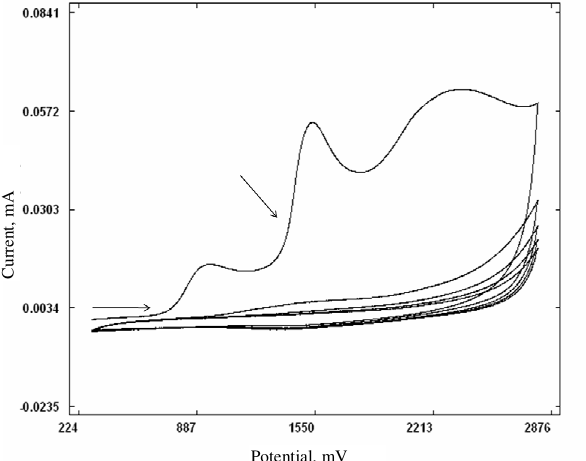
Figure 2 . Cyclic voltammogram of HIBD in the presence of 0.1 M TBATFB in acetonitrile, +0.3 V and +2.8 V potential range using 100 mV s -1 with 5